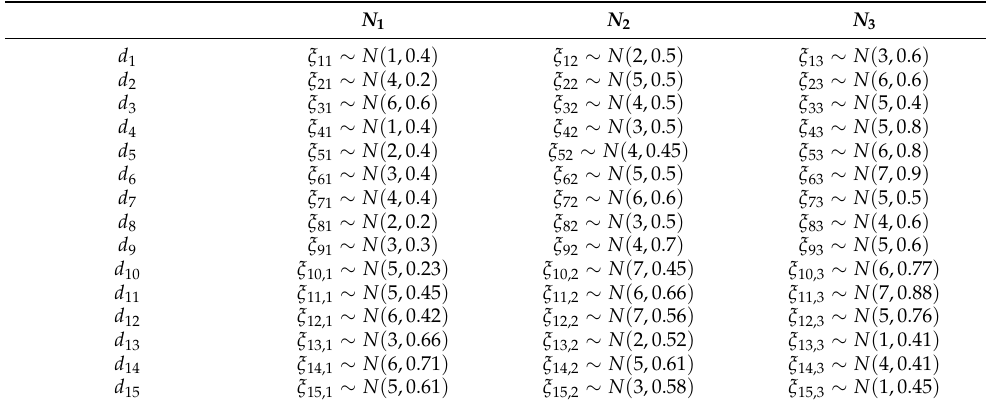
Table 3. ξ ik ∼ N ( µ ik , σ ik ) , i = 1,2, . . . ,15, k =